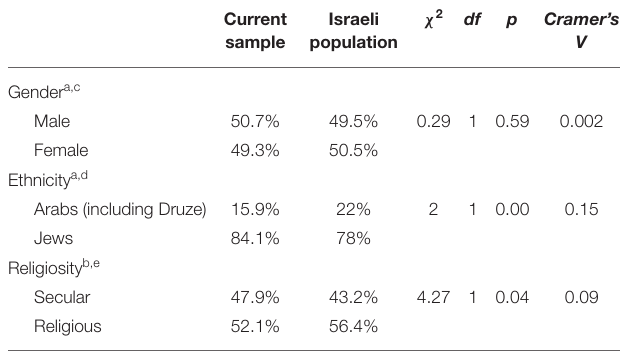
TABLE 2 | Distribution of gender, ethnicity, religiosity, and educational levels in this study’s sample ( N = 509) and in the Israeli population. Current sample